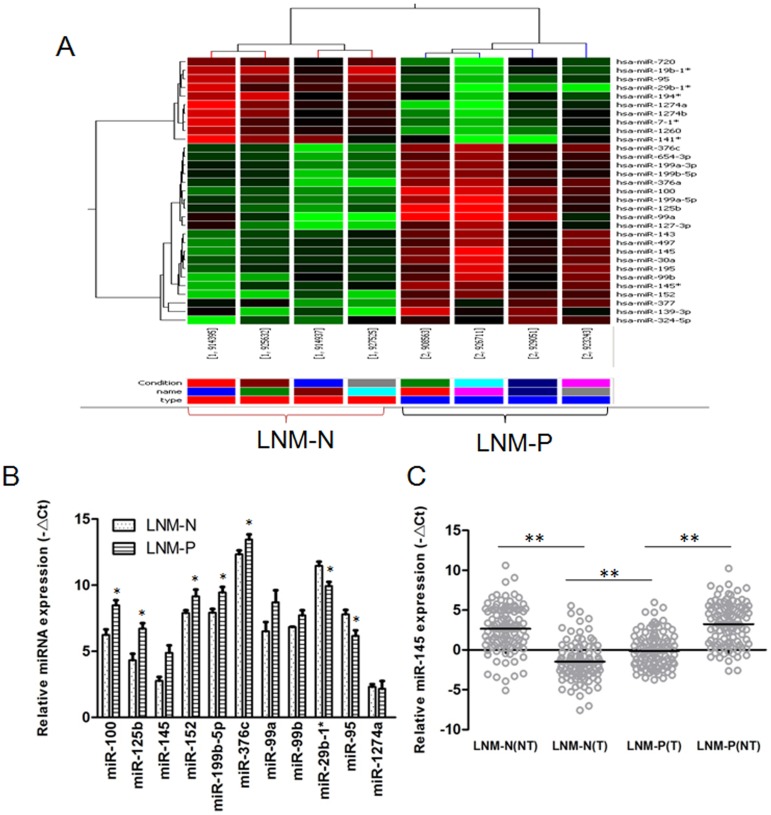
MiRNA expression profiles in CRC with or without lymph node metastasis.A. The certified result of microarray analysis. Hierarchical clustering of 32 significantly dysregulated miRNAs expression profiles in human primary colorectal cancer tissues derived from colorectal cancer patients with (LNM-P, n = 4) or without (LNM-N, n = 4) lymph node metastasis. B.Validation of selected miRNAs predicted to be dysregulated in CRC with or without lymph node metastasis using qRT-PCR in the same tissues used for microarray analysis. Data shown in B is representative of three independent experiments, and presented as fold expression normalized to U6 ± SD (standard deviation).C. QRT-PCR analysis of the relative expression of miR-145 in additional 202 (LNM-N = 99; LNM-P = 103) cases of human CRC tissues, including tumor sample (T) and matching non-tumor tissue sample (NT) from the same patient. Each sample was analyzed in triplicate and normalized to U6. * P<0.05, ** P<0.01.